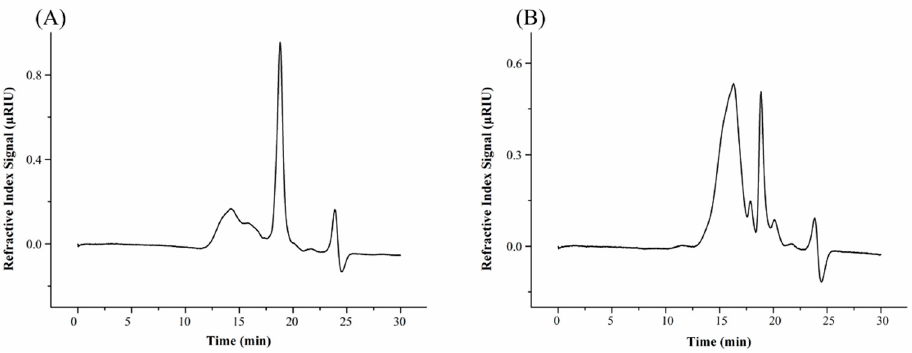
Figure 2. Gel permeation chromatogram pro fi les of U-SDF ( A ), M-SDF ( B ).